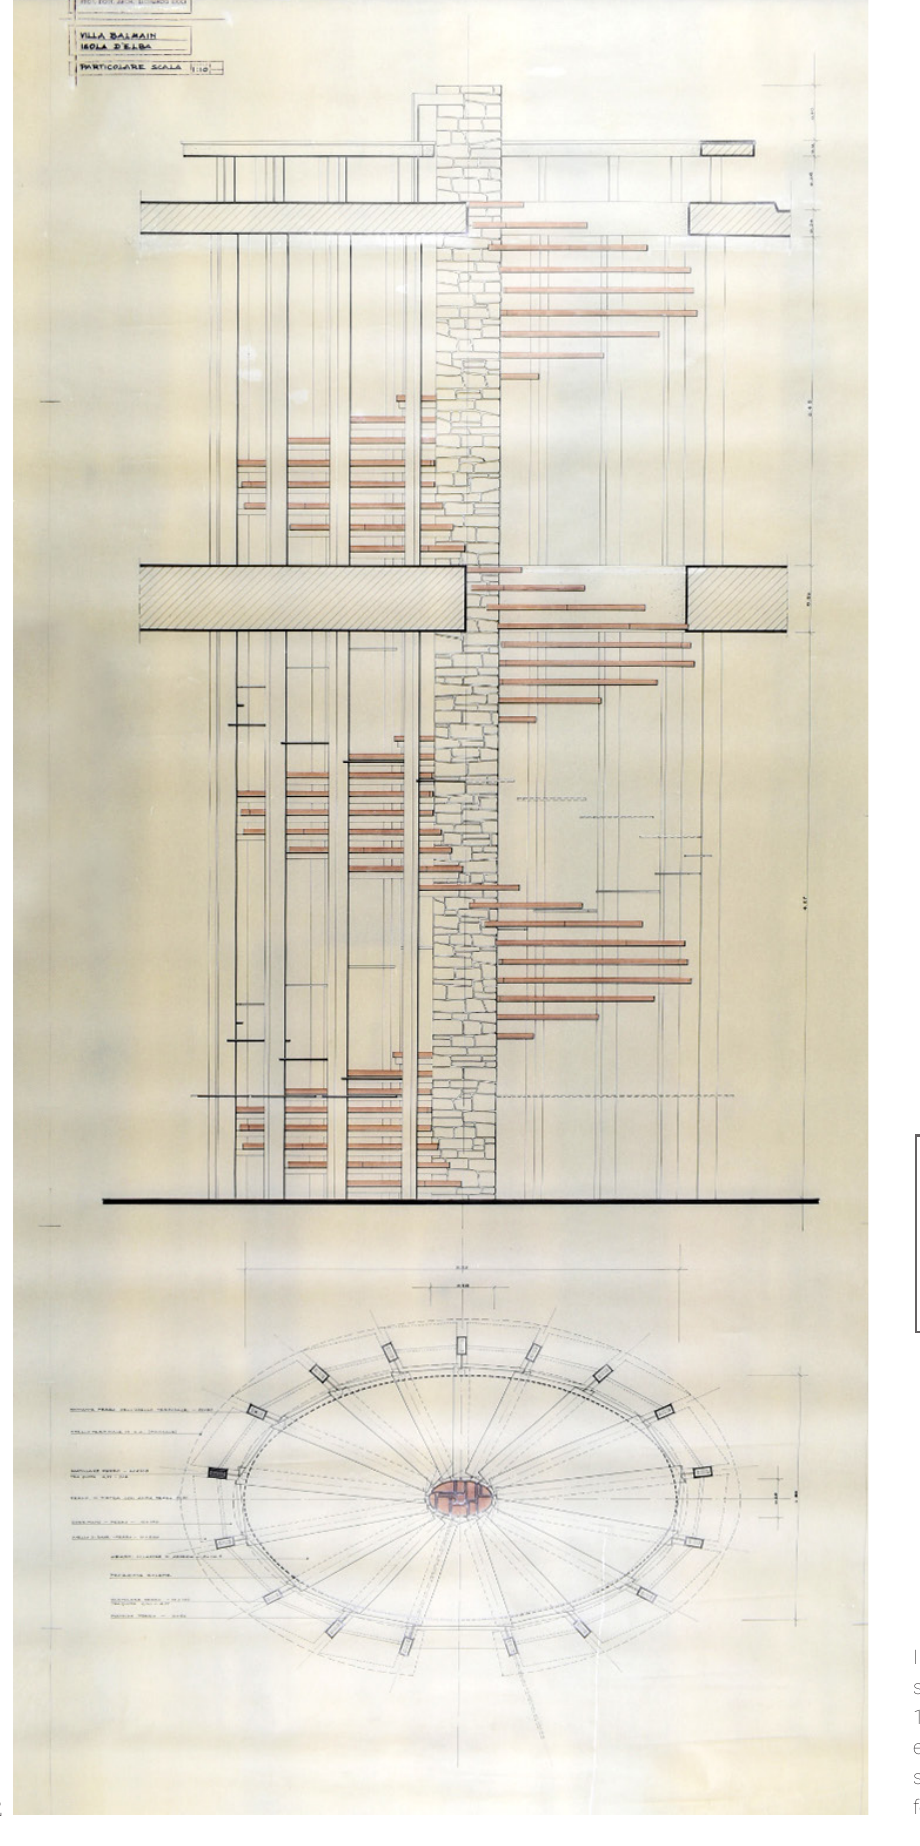
IMG.4: longitudinal and cross section of the staircase, scale 1:10, ink and felt-tip on transpar - ency, CSR; IMG.5: detail of the staircase, scale 1:10, ink and felt-tip on transparency,